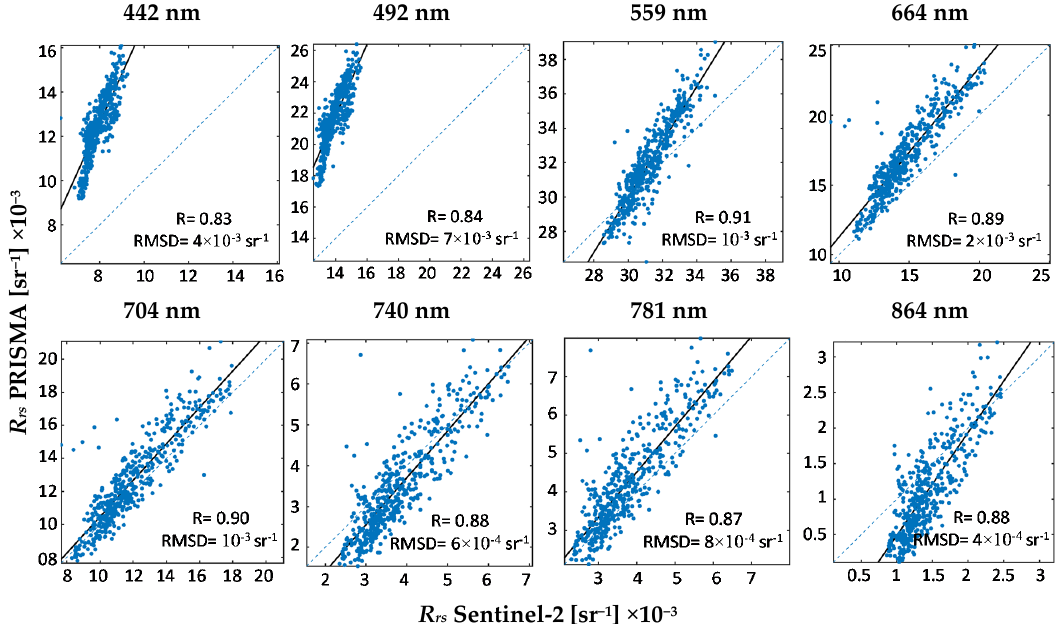
Figure 4. R rs spectra for the stations St1 ( a ) and St2 ( b ) in Lake Trasimeno based on PRISMA and Sentinel-2 acquisitions on 23 April 2020.